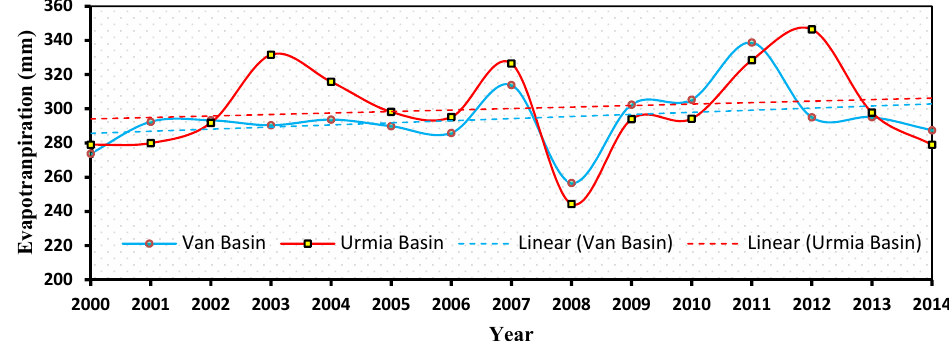
Figure 10. Mean annual time series of ET in the LU and LV basins, based on MODIS data.